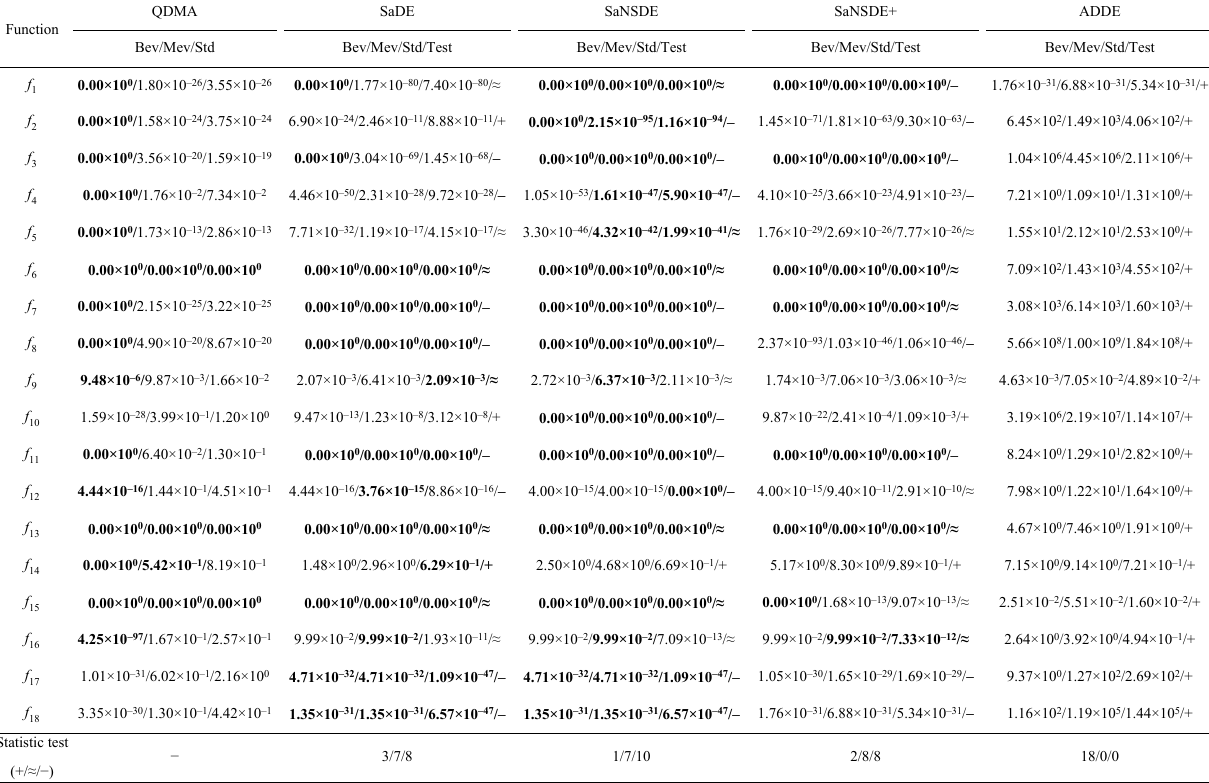
Table A2 Comparison of QDMA and different DE variants on 10 D